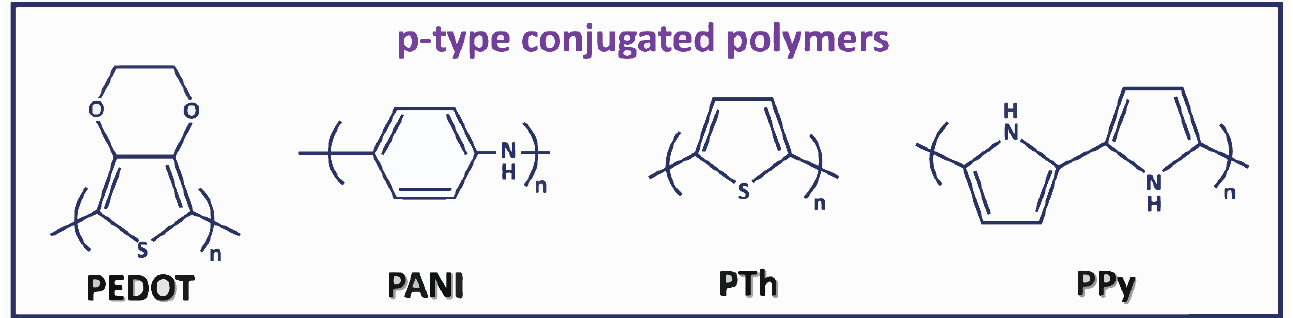
Figure 5. The chemical structure of the most applicable p ‐ type conjugated polymers, such as poly(3,4 ‐ ethylenedioxythiophene) (PEDOT), polyaniline (PANI), polythiophene (PTh), and polypyrrole (PPy).